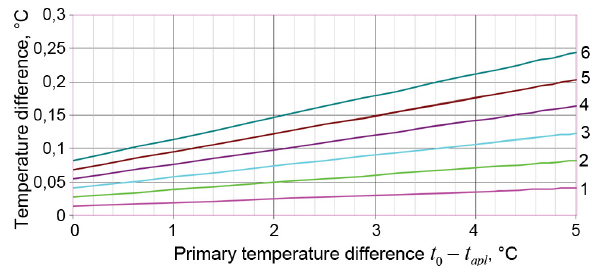
Fig. 2. The dependence of plant leaf temperature change ∆ t on the initial difference in temperatures between the plant leaf surface and the environment when the plant leaf changes its position with respect to the radiation source at angle β = 30 Plant leaf thickness is 0.2 mm. The duration of the changed leaf position with respect to the Sun: 1 − 1 s; 2 − 2 s; 3 − 3 s; 4 − 4 s; 5 − 5 s; 6 − 6